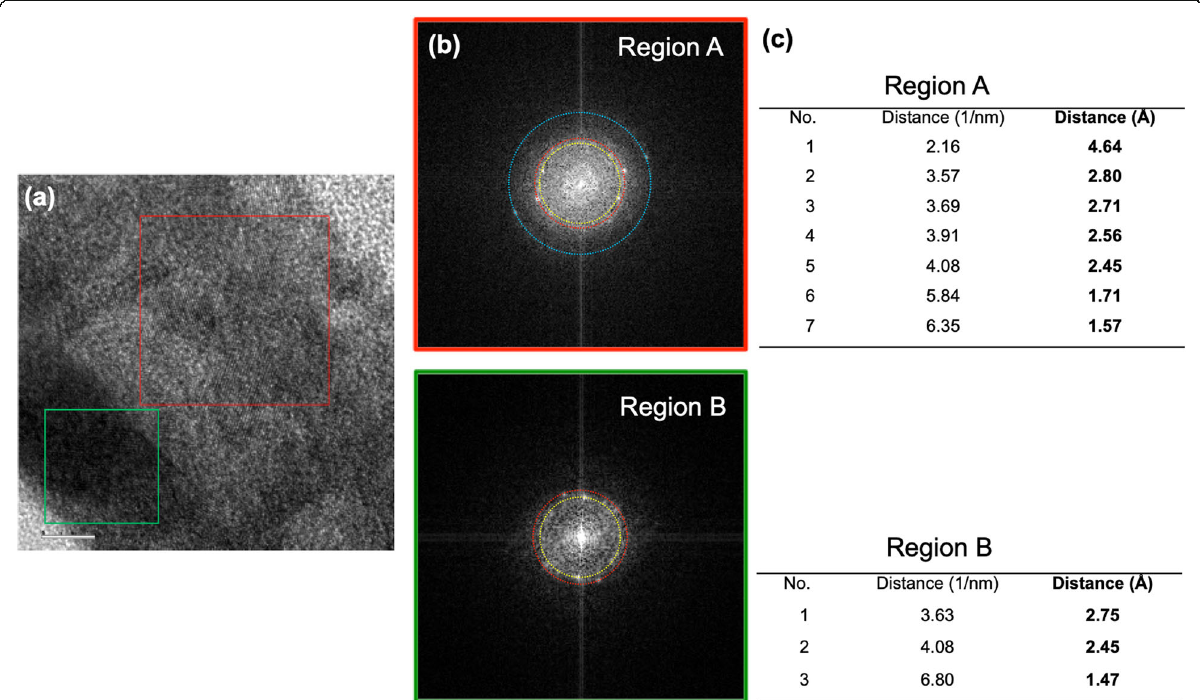
Fig. 7 a High-resolution image of a ZTO film. b Fast Fourier transform (FFT) of the region A (red) and region B (green). c List of d -spacing values in the regions A and